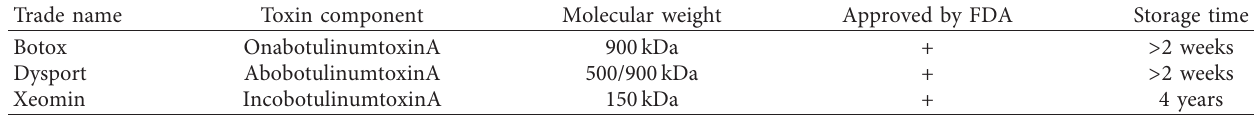
Table 1: Botulinum toxin injectable products.